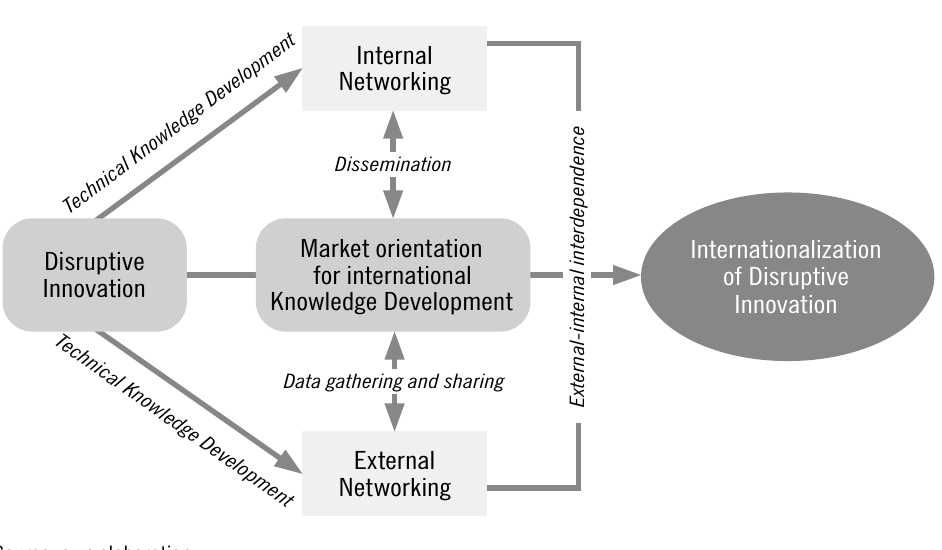
Figure 2. The knowledge after the development phase of SMEs internationalization of MO disruptive